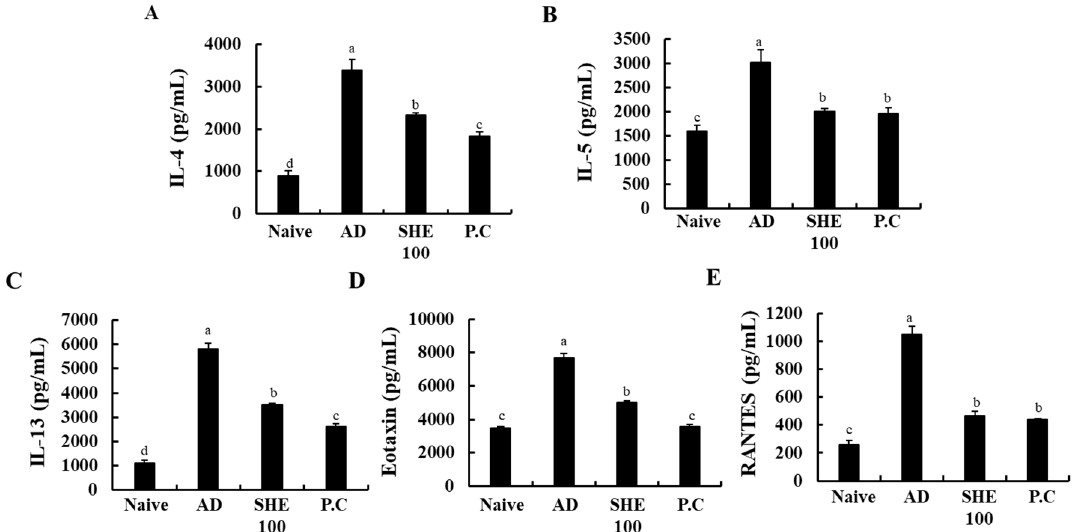
Figure 6. The production of IL-4 ( A ), IL-5 ( B ), IL-13 ( C ), Eotaxin ( D ), and RANTES ( E ) in HDM / DNCB-stimulated mice serum. Experiments were performed in triplicates, and the data were expressed as mean ± SD. a-dValues with different alphabets were significantly different at p < 0.05 (n = 8).